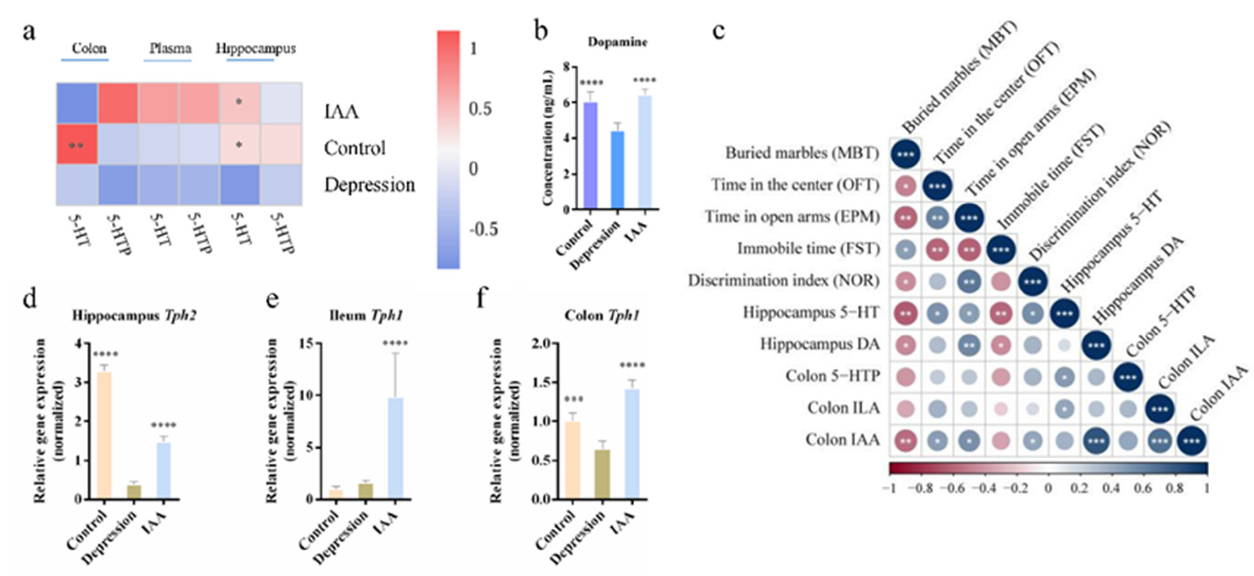
Figure 3. Variation of the serotonergic system and dopamine levels in mice. ( a ) Analysis of serotonin and 5-hydroxytryptophan in the plasma, colon content and hippocampus. ( b ) Concentrations of dopamine in the hippocampus of three groups. ( c ) Correlation analysis of behavioural performance and metabolites from host and gut microbiota. ( d – f ) Expression level of tryptophan hydroxylase- coding gene in different tissues. Data represent means and SD, compared with the depression group, * p < 0.05, ** p < 0.01, *** p < 0.001, **** p < 0.0001 compared with UCMS-treated group, one-way ANOVA followed by Tukey’s post hoc test.